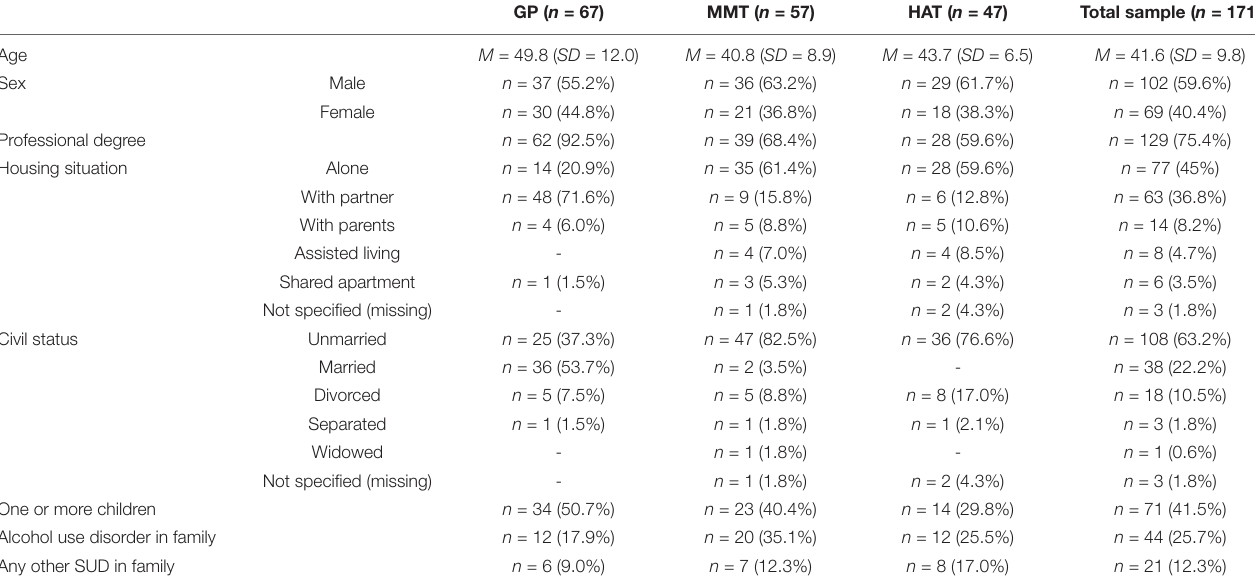
TABLE 1 | Sample characteristics.